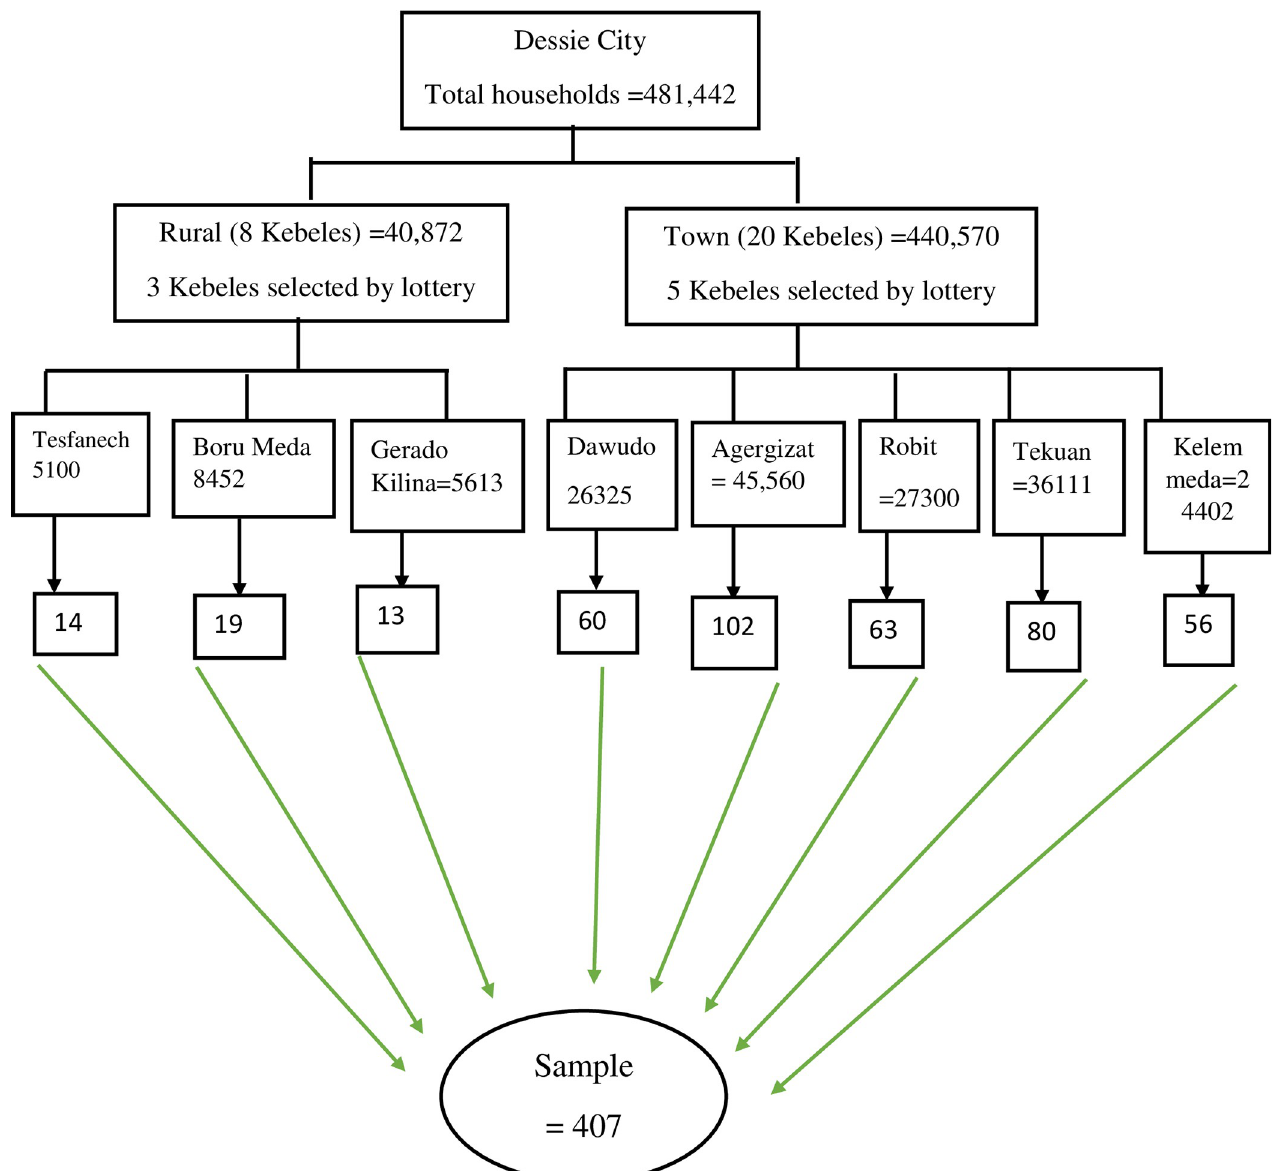
Fig 1. Schematic presentation of the sampling procedure for selecting study participants, Dessie City, north east Ethiopia, 2021 (n = 407).